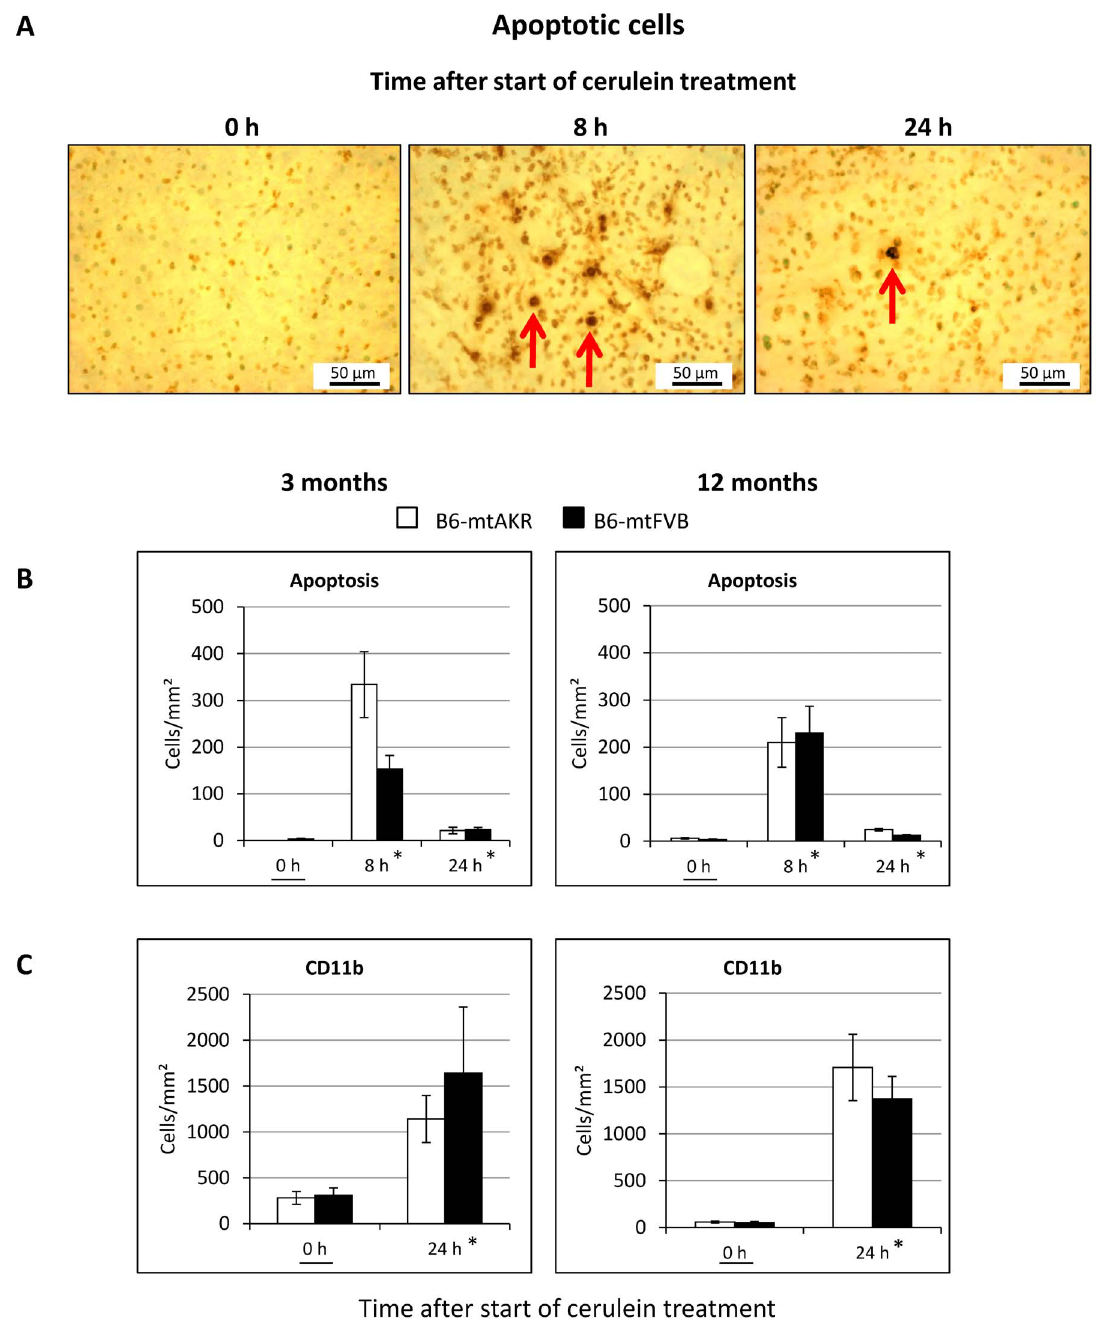
Figure 3. Detection of apoptotic cells and CD11b-positive cells in pancreatic tissue of B6-mtAKR and B6-mtFVB mice. Pancreatic sections of 3 and 12-month-old mice at the indicated time points after initiation of cerulein treatment (n=5–6 per group) were stained with the ApopTag Kit for the detection of apoptotic cells (A, B), or processed applying the ABC technique and a CD11b-specific antibody (C). (A) Representative photographs of apoptotic cells (indicated by arrows) in the tissue of 12-month-old B6-mtFVB mice. (B, C) Positive-stained cells were counted, and mean values 6 SEM were calculated. (B) *P U , 0.0166 vs. 0 h with Bonferroni-adjusted a =0.0166. (C) *P U , 0.001 vs. 0 h each.